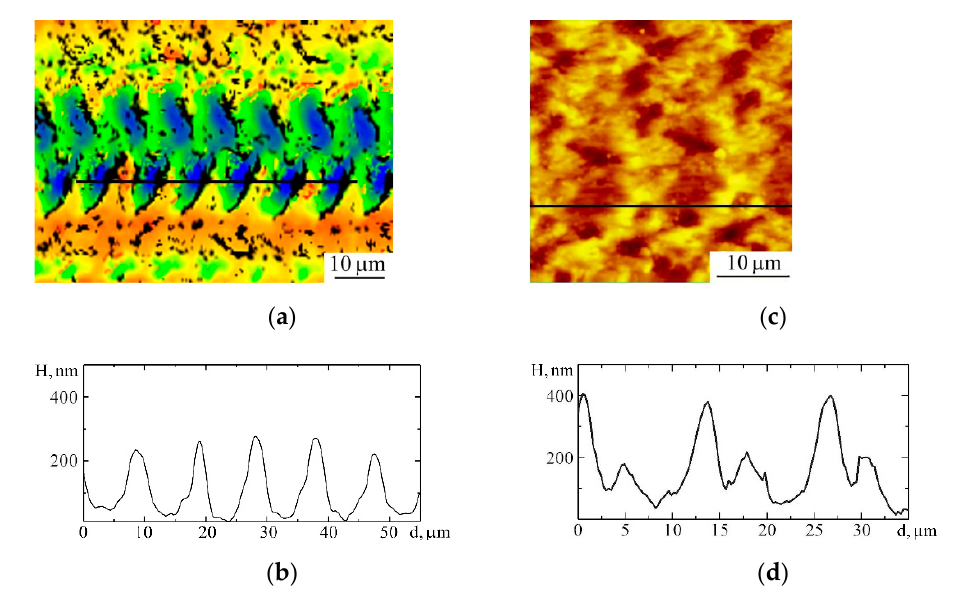
Figure 1. The surface morphology ( a , c ) and corresponding profilograms ( b , d ) of the CP-Ti sample after the ultrasonic impact treatment (UIT) processing. Optical profilometry ( a , b ) and atomic force microscopy ( c , d ).